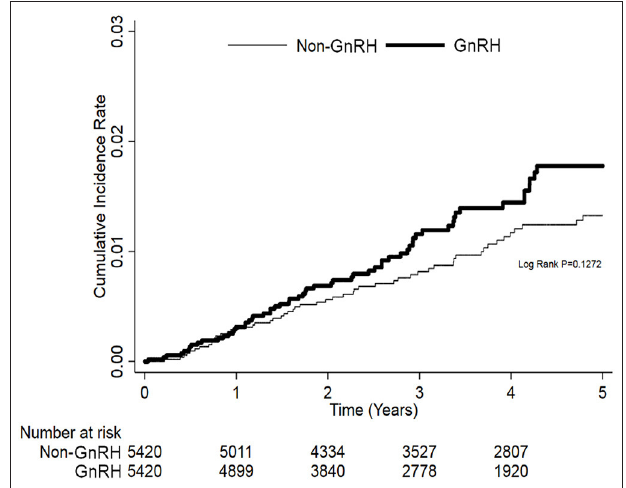
FIGURE 2 | The cumulative incidence rate of 5 years venous thromboembolic events (VTEs).